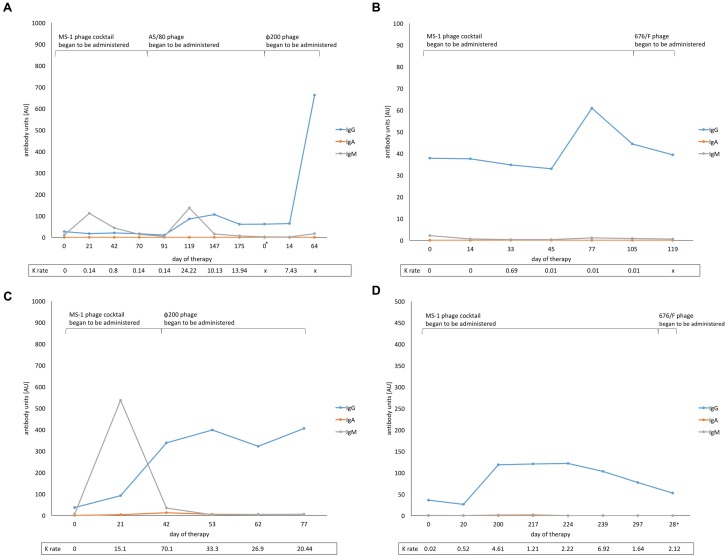
Levels of anti-MS-1 phage antibodies (IgG, IgA, IgM) before and during phage therapy and antiphage activity of sera (AAS, K rate) in four patients with the largest number of control visits. (A) Patient 4; ∗means 5-month break between successive cycles of phage treatment, (B) Patient 6, (C) Patient 8, (D) Patient 10; ∗means 8-month break between successive cycles of phage treatment. x, K rate was not estimated.